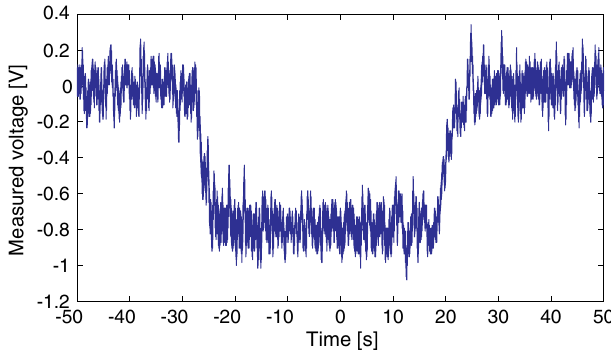
FIG. 17. Suppression of secondary electrons as a function of the voltage applied to the suppressing electrode.